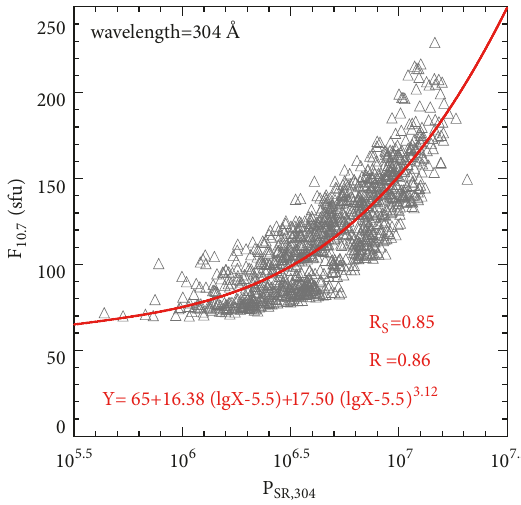
Figure 3: Scatter diagrams with the nonlinear function (solid red line) of P SR ,304 and F 10.7 from May 2010 to December 2015. The Spearman correlation coefficient (R 𝑆 ) is between P SR ,304 and F 10.7 , and the Pearson correlation coefficient (R) is between fitted Y and F 10.7 . The function of the solid red line is Y = 65+16.38( lgX −5.5)+ 17.5( lgX − 5.5) 3.12